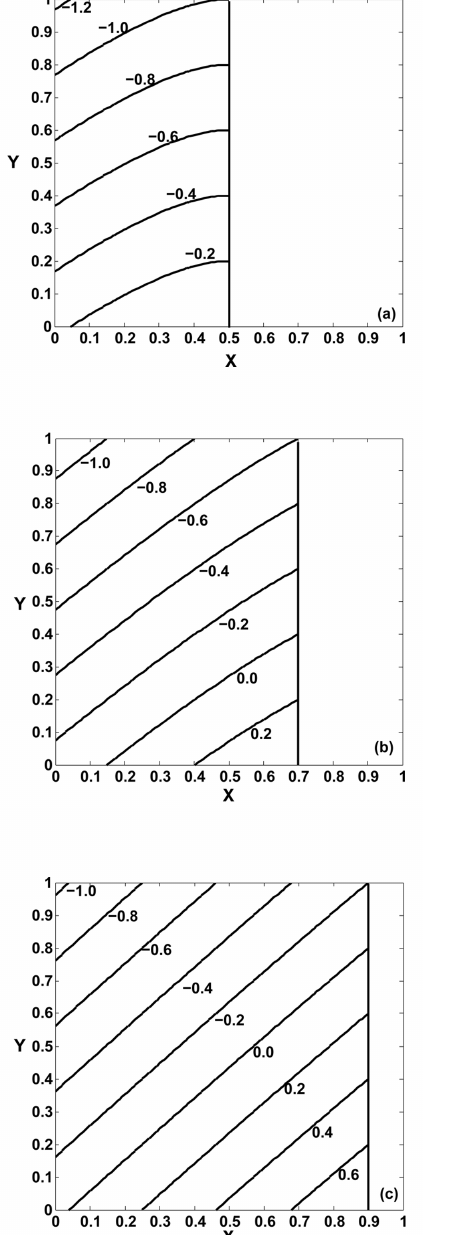
Fig. 4. Contour plots of 1T 1 /2 on different sections of H : (a) Z 0 = − 0 . 5, (b) Z = − 0 . 3, (c) Z = − 0 . 1 ( α = 1, V 2 = 1). 0 0